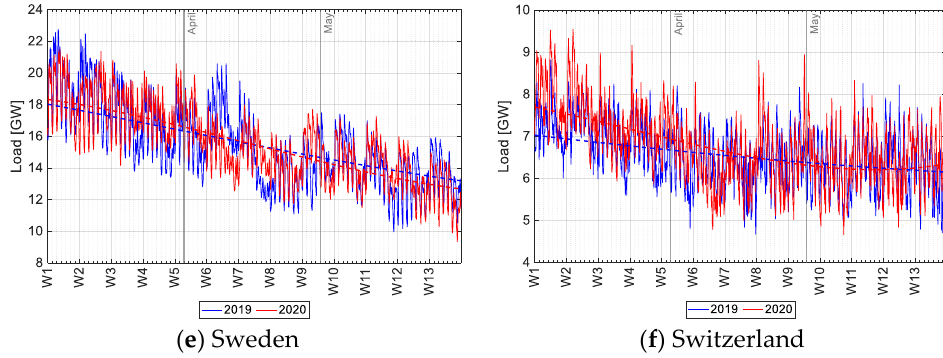
Figure 3. Weekly power profile during pandemic for selected countries.